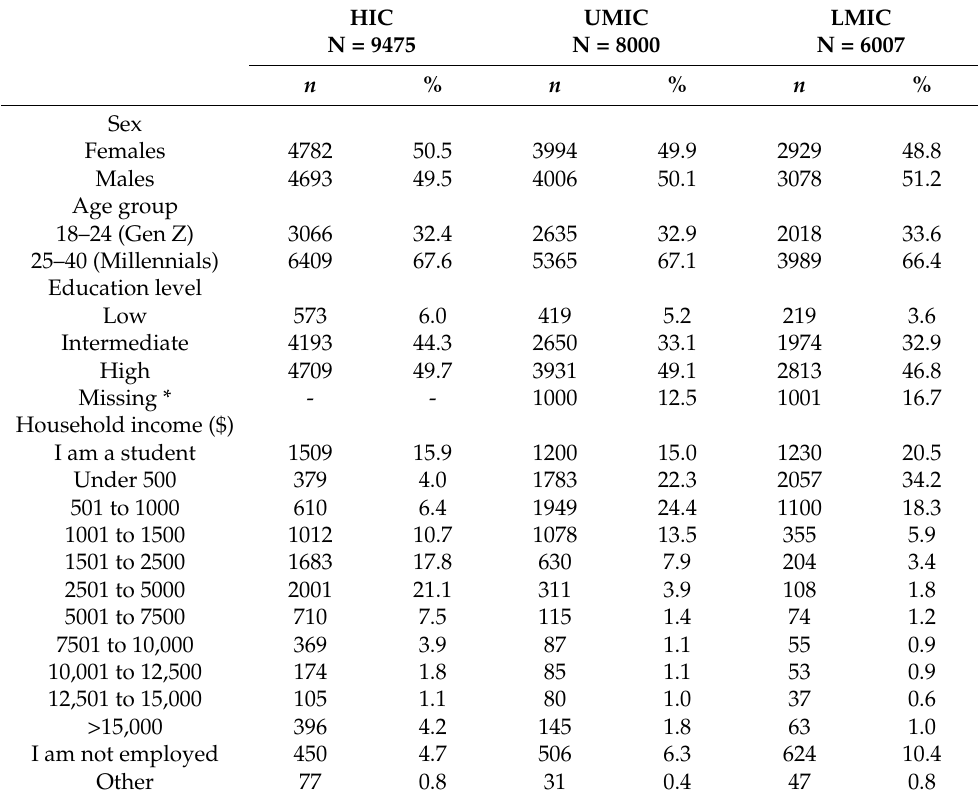
Table 1. General characteristics of the 23,482 young respondents to the international survey “Social Media & COVID-19” by sex, age group, education level, and household income in the three income groups (according to the World Bank classification of income